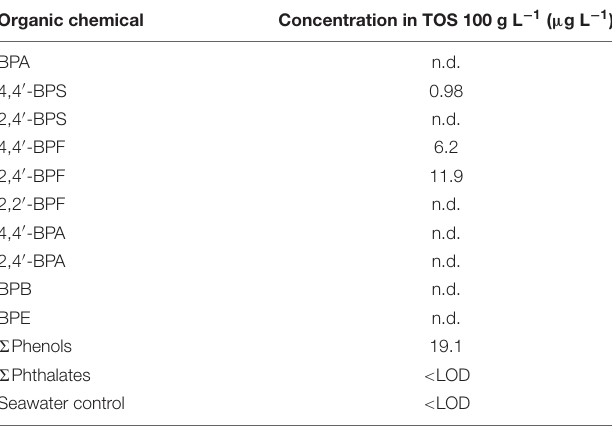
TABLE 5 | Concentration of phenols and total phthalates in the seawater leachate of TOS (100 g L − 1 ). Organic chemical